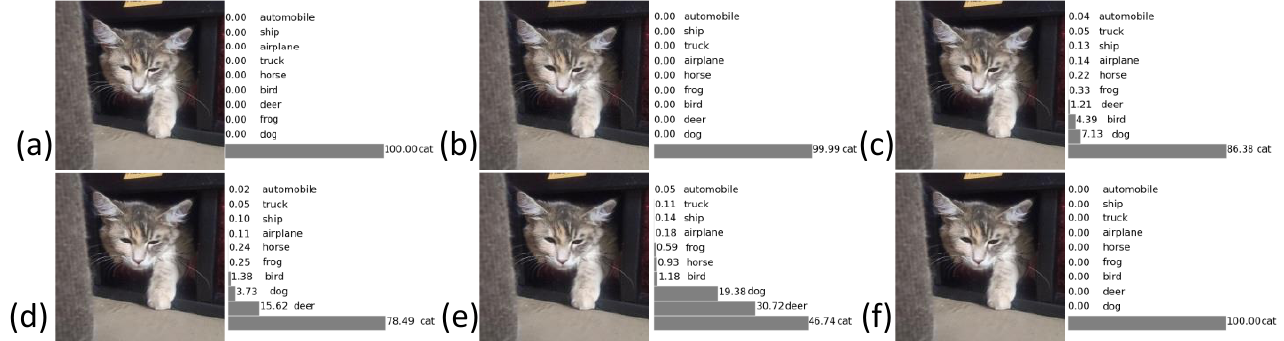
Figure 5. Results of image “ Cat_ Maine_Coon ” recognition: ( a ) original image; ( b ) image noisy with random-valued impulse noise of intensity 1%; ( c ) image cleaned by the method [28]; ( d ) image cleaned by the method [25]; ( e ) image cleaned by the method [27]; ( f ) image cleaned by the proposed method.